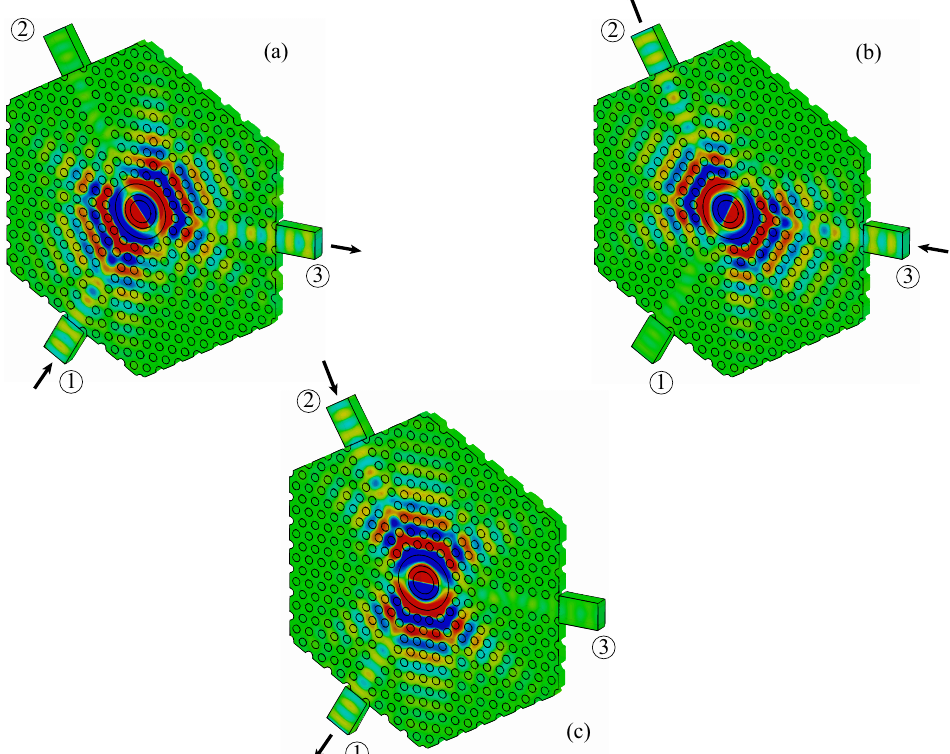
Figure 11. H z distribution at the center frequency f 0 obtained from 3D simulations performed with CST Studio Suite for excitation at ( a ) port 1, ( b ) port 3, and ( c ) port 2. The calculated values for insertion loss, isolation, and reflection levels are − 1 dB, − 14 dB, and − 20 dB, respectively, at the center frequency f = 193.3862 THz (correspond- 0 ing to λ 0 = 1550.227 nm). The frequency band of the circulator is highlighted in yellow in Figure 10 and its upper and lower limits are f 1 = 193.3842 THz and f 2 = 193.3892 THz, with an operating bandwidth ∆ f = f 2 − f 1 = 5